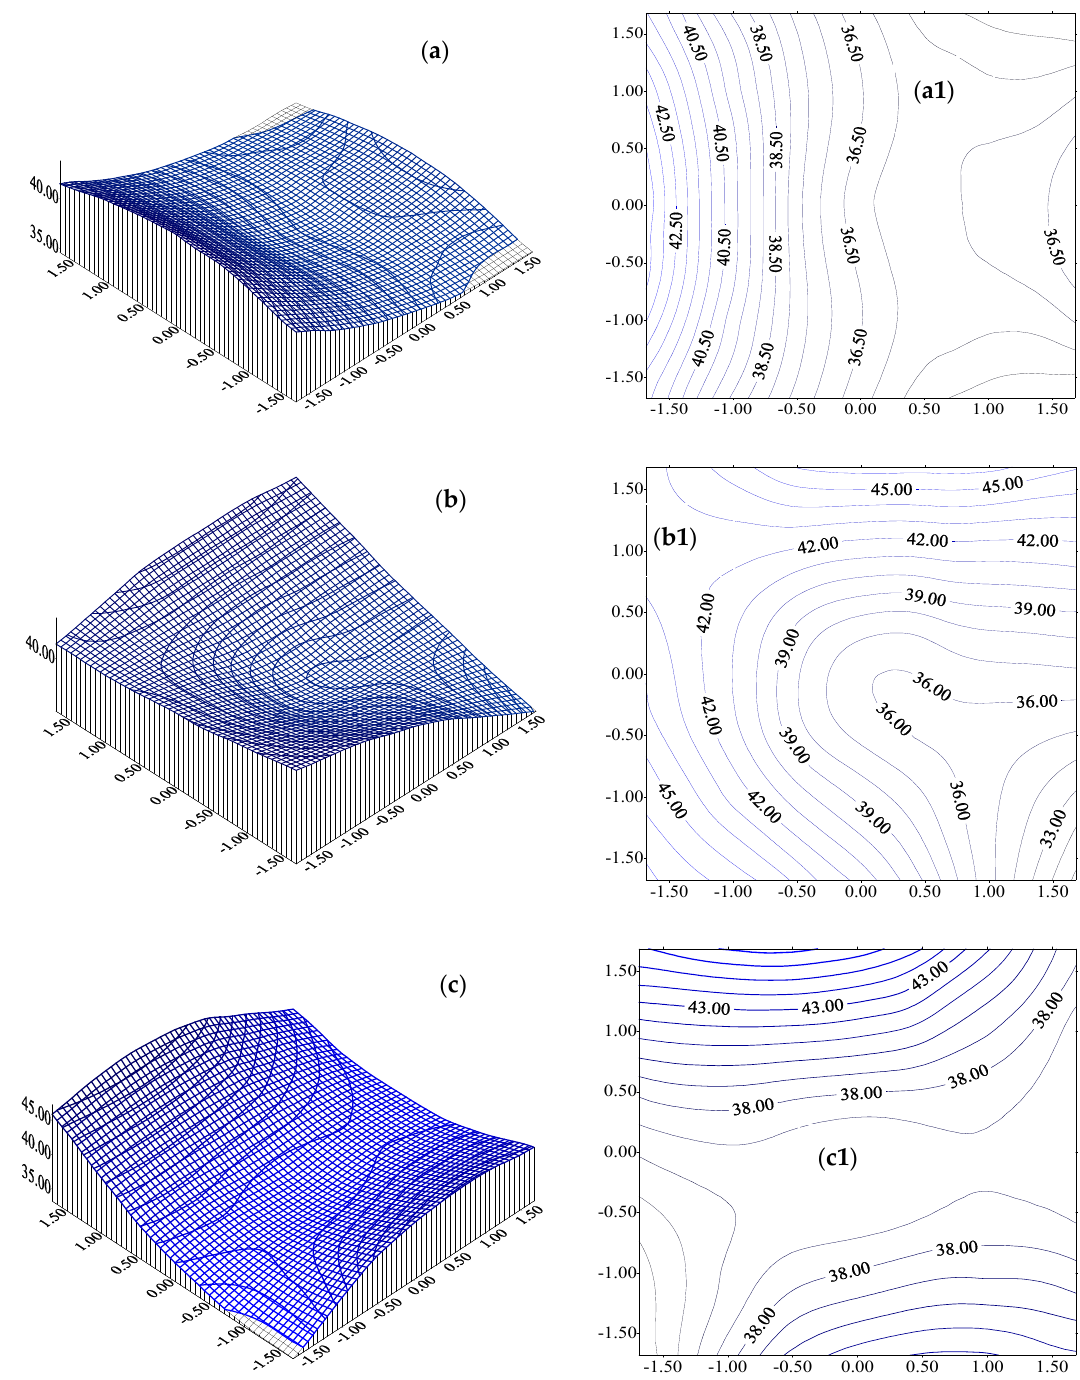
Figure 8. Variation in the WW suspended solids removal ( Y 1 ) vs. two independent variables (one variable was maintained at the basic value) associated with its isoline: ( a ) Y 1 = Y ( X 1 , X 2 ,0); ( a1 ) isolines − Y 1 ( X 1 , X 2 ,0); ( b ) Y 1 = Y ( X 1 ,0, X 3 ); ( b1 ) isolines − Y 1 ( X 1 ,0, X 3 ); ( c ) Y 1 = Y (0, X 2 , X 3 ); ( c1 ) isolines − Y 1 ( 0 ,X 2 ,X 3 ).